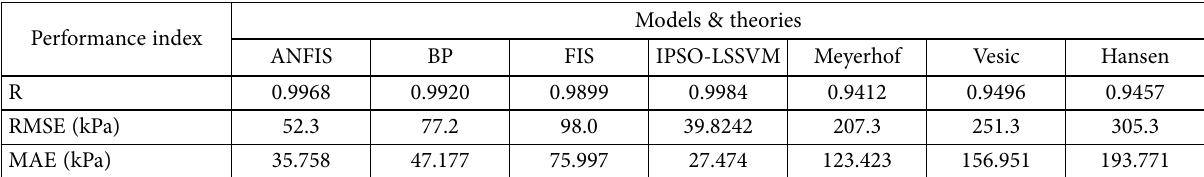
Table 4. Prediction performance statistics of all the models &